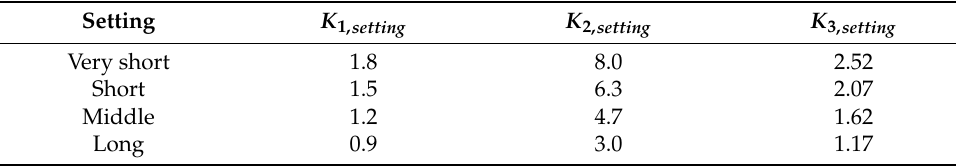
Table 3. Values of k 1, setting , k 2, setting and k 3, setting .